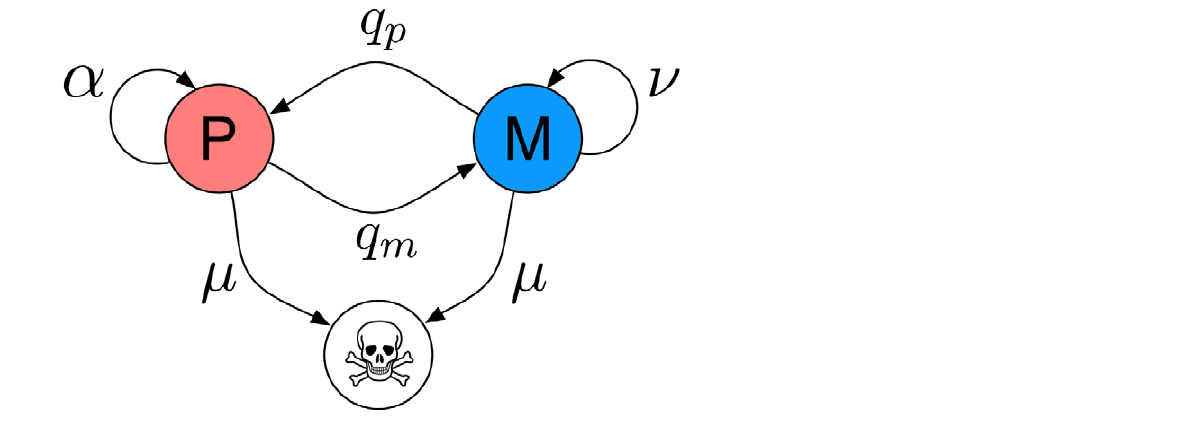
PLoS Computational Biology |